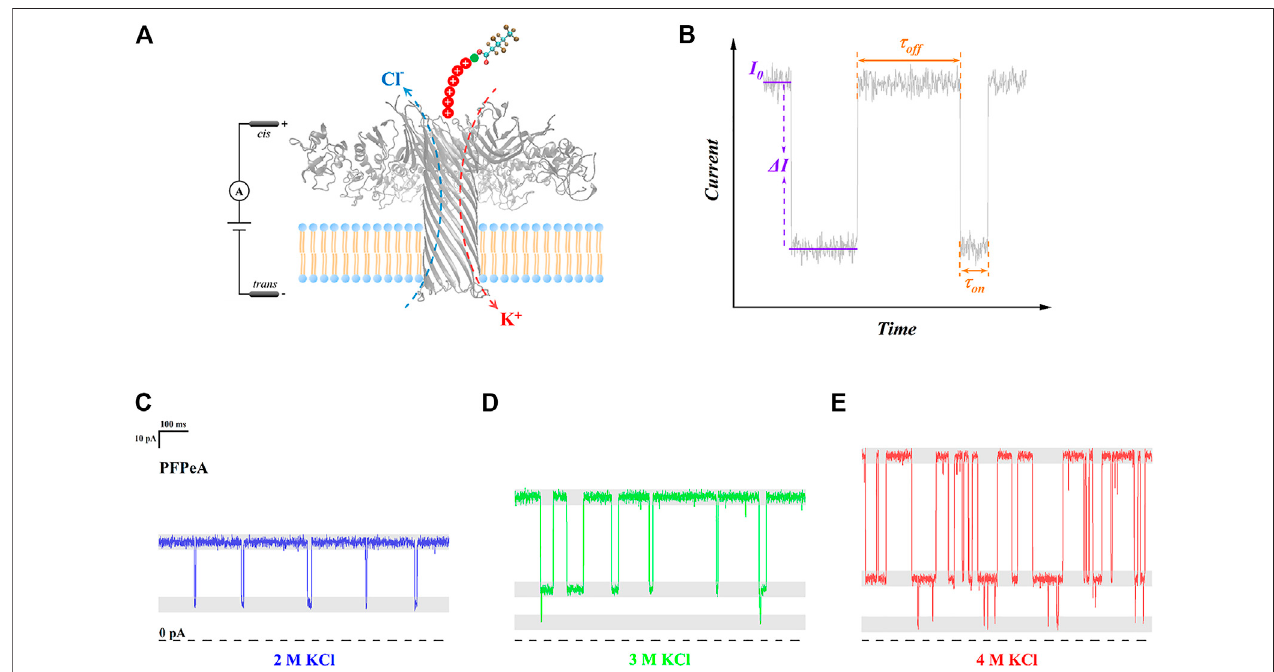
FIGURE 1 | (A) Schematic illustration of PFCAs determination by aerolysin nanopore SMSs. (B) A typical current trace highlighting the open-pore current (I 0 ), blockade ( Δ I/I 0 ), dwell time ( τ on ), and interval time ( τ off ). Typical current trace of PFPeA detection in (C) 2 M KCl, (D) 3 M KCl, and (E) 4 M KCl electrolytes.